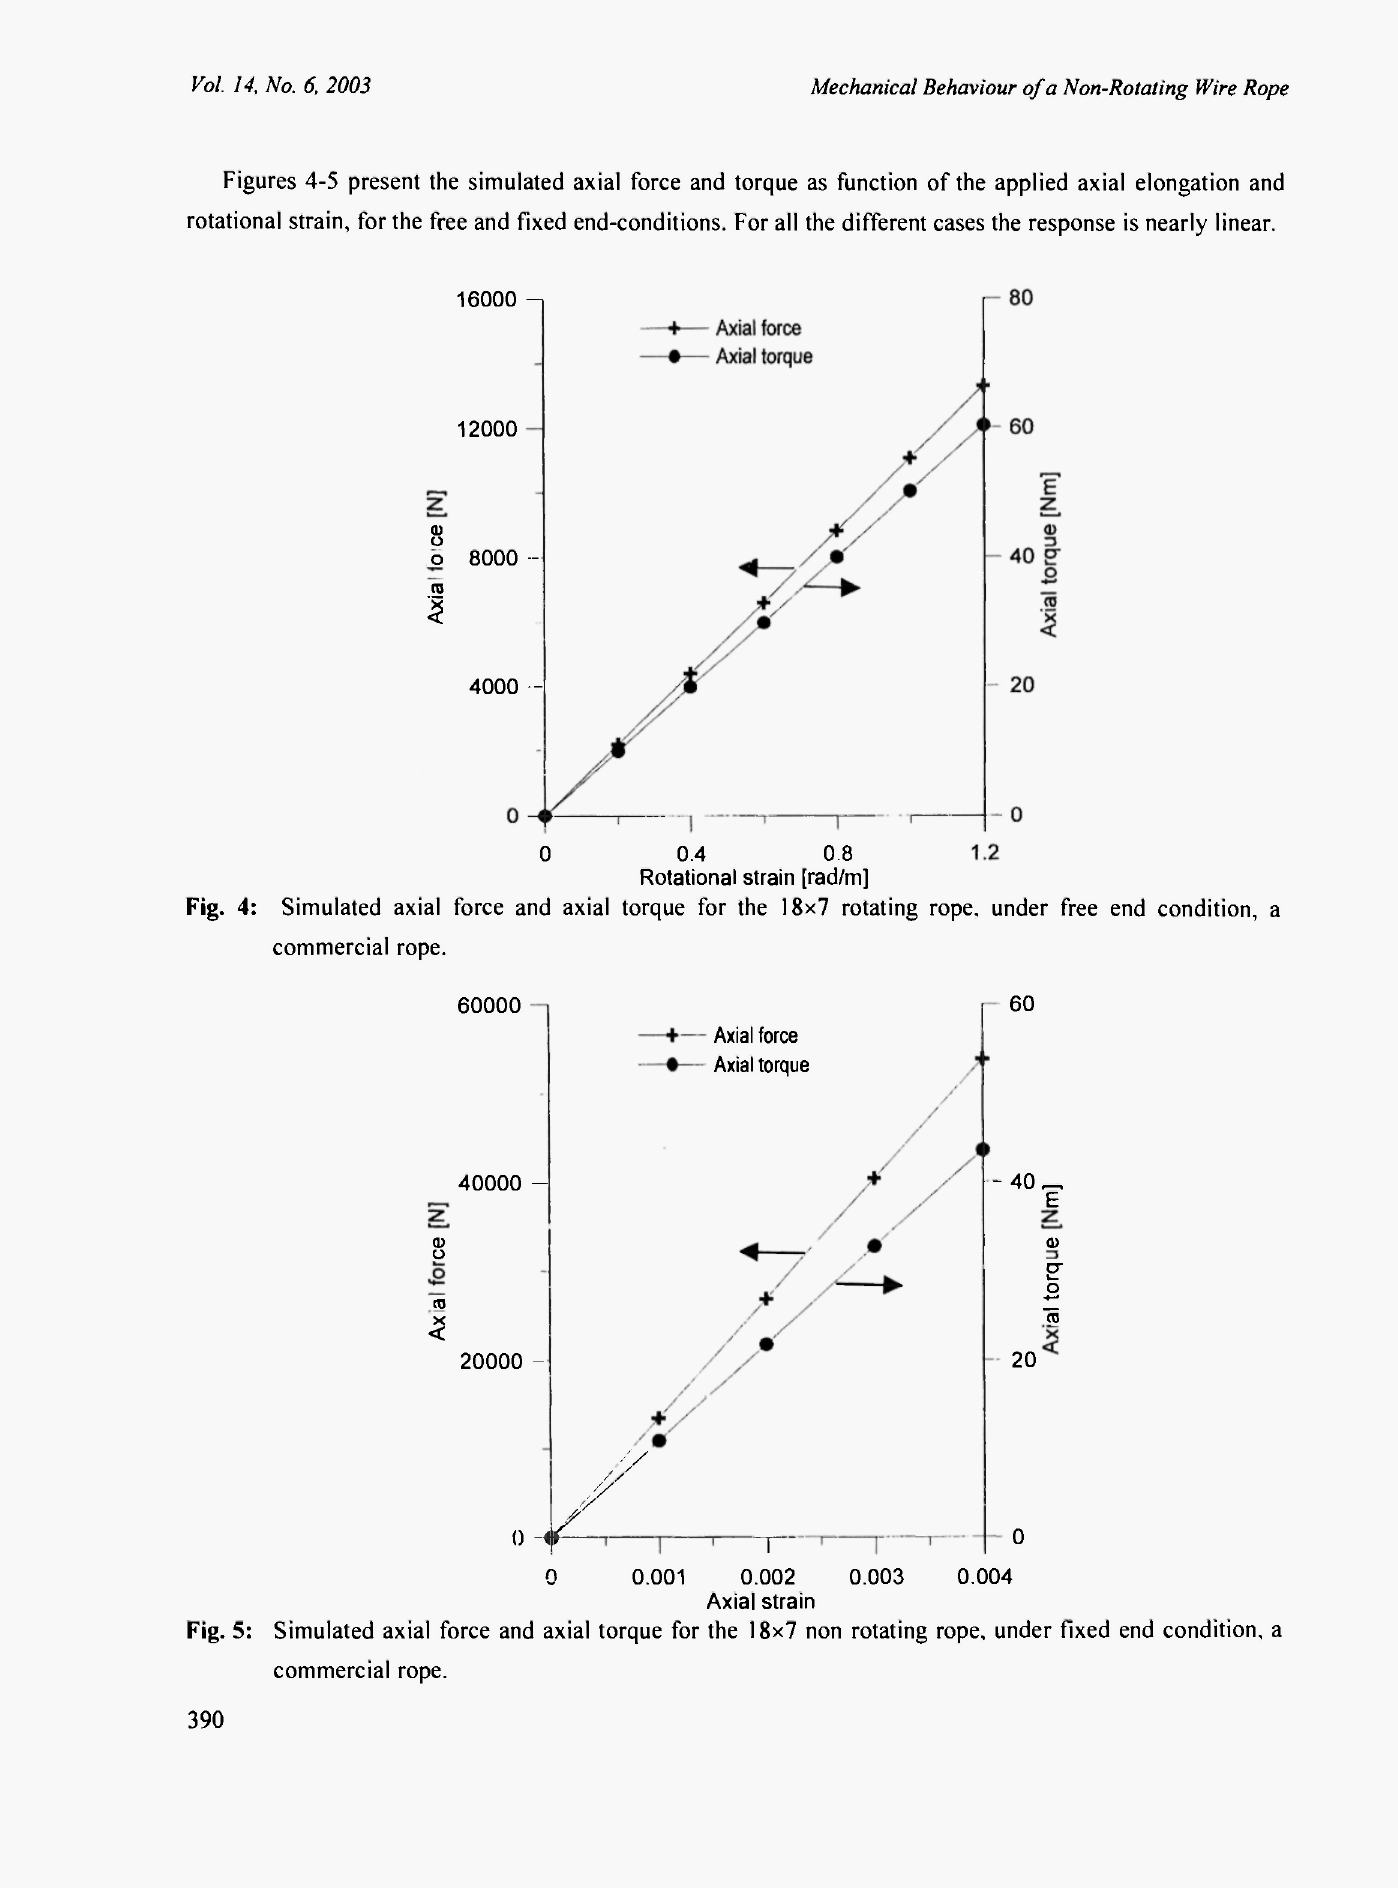
Fig. 5: Simulated axial force and axial torque for the 1 8x7 non rotating rope, under fixed end condition, a commercial